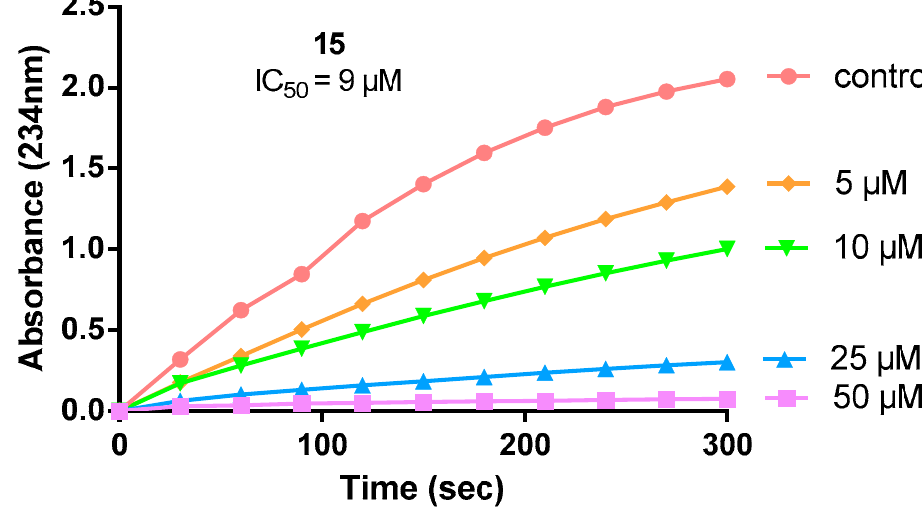
Figure 3. Representative graph showing the time-dependent inhibition of LOX-3 by different concen- trations of derivative 15 .